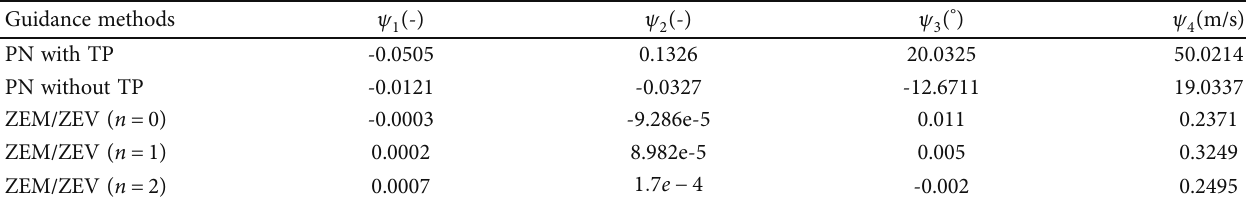
Table 2: Simulated comparison of the results for an interception of the maneuver target under multiple guidance methods. Guidance